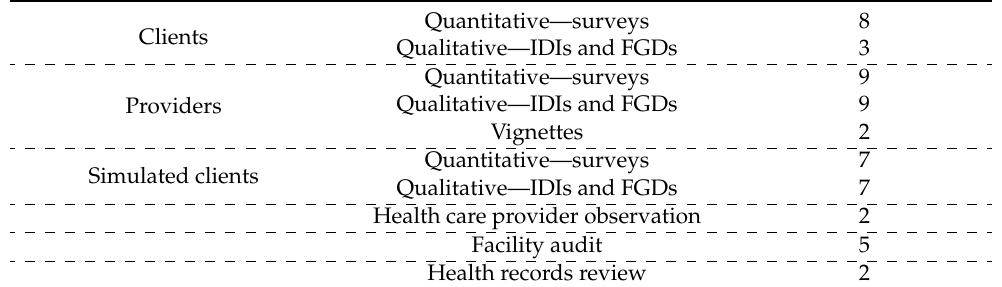
Table 5. Point of service assessment